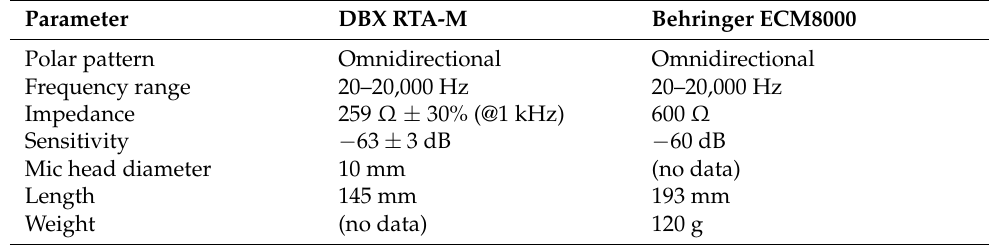
Table 4. Detailed specifications of microphones of two